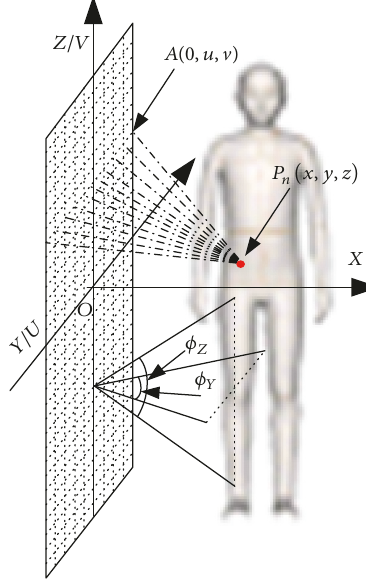
Figure 1: Planar scanning geometries for concealed weapon detec-